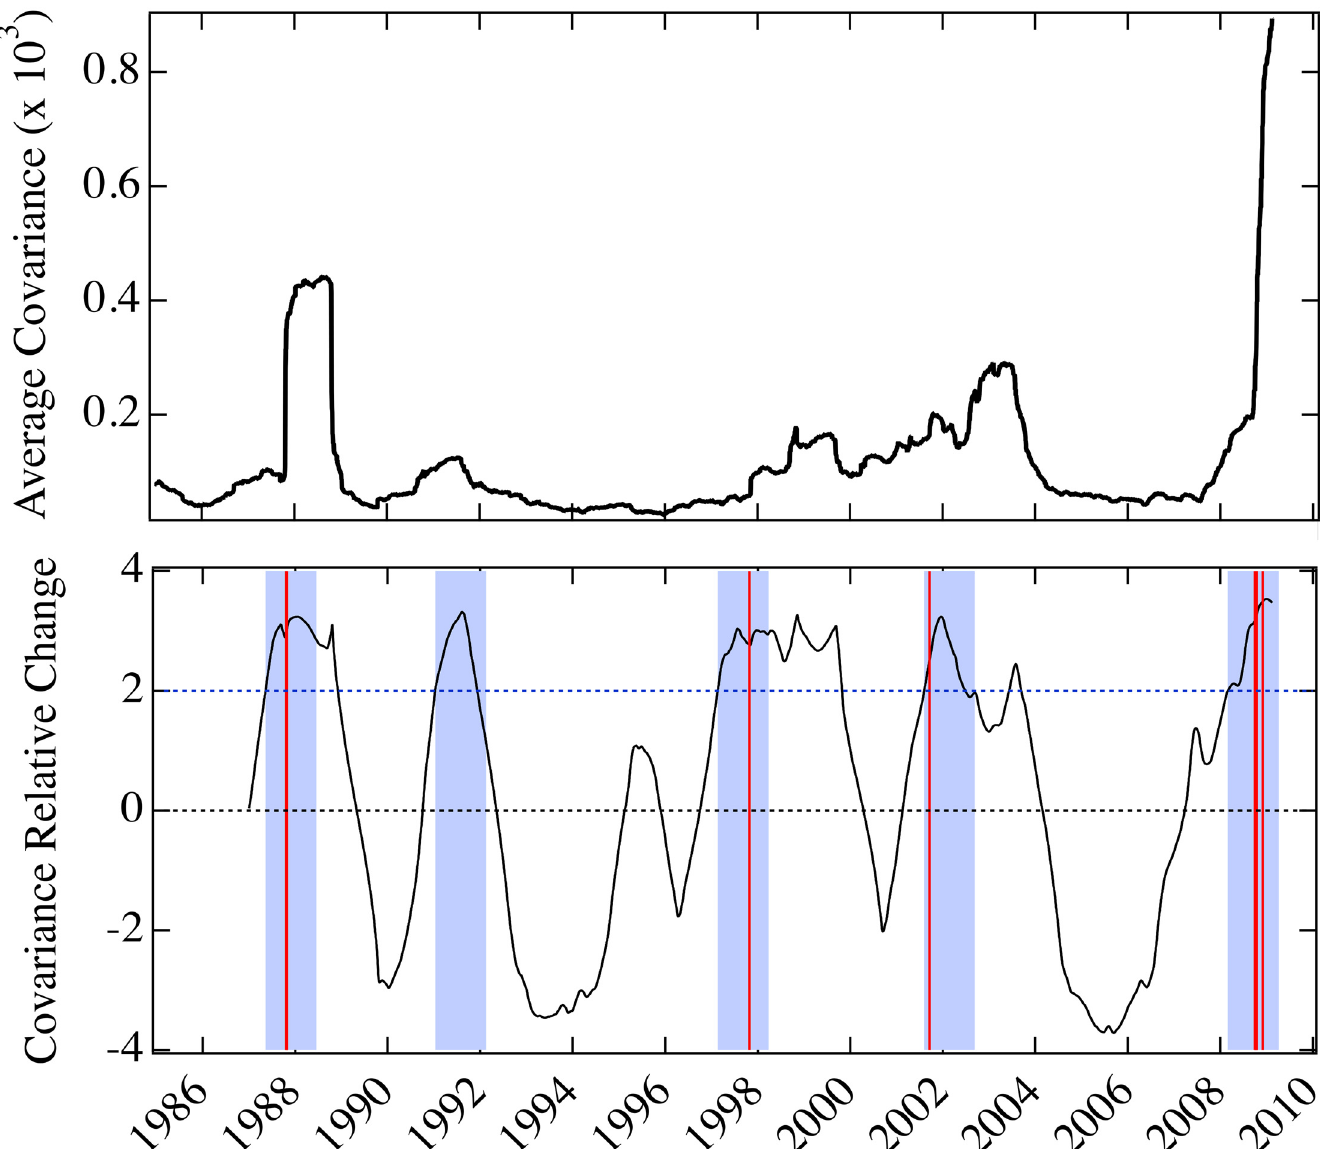
Fig 8. Annual relative change in covariance for the period 1985 – 2010. Top panel is the average covariance between price returns of the underlying components of the S&P 500 index, from 1985 to 2010. Bottom panel is the annual change of the average covariance as a fraction of its standard deviation computed over the previous year. Four year-long windows (shading) follow two standard deviation increases in the average covariance greater than twice the standard deviation from one year earlier, after periods of decline. One day crashes are as in Fig 3 (vertical red lines). This indicator yields 4 true positives and 1 false